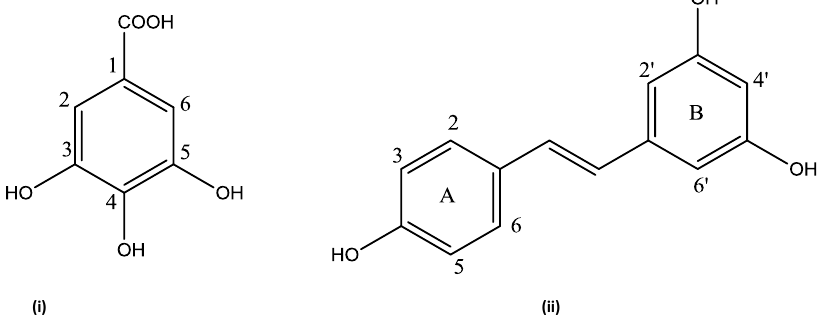
Figure 7. The structure of identified compounds ( i ) Gallic acid ( ii ) resveratrol from RFPA.